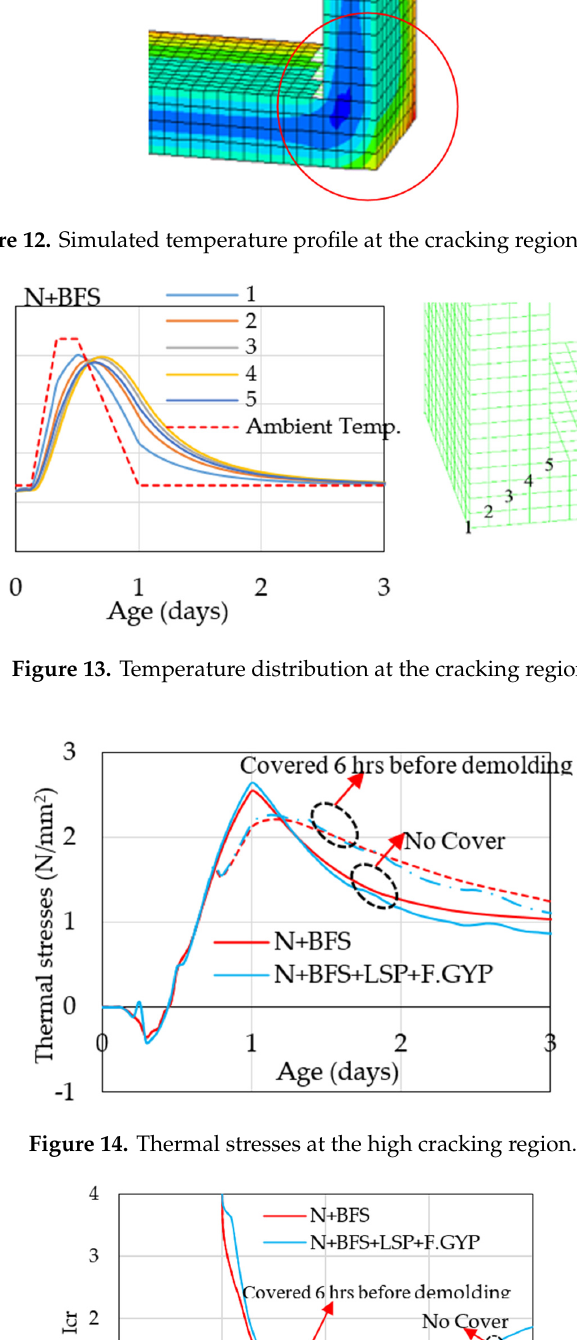
Figure 14. Thermal stresses at the high cracking region.